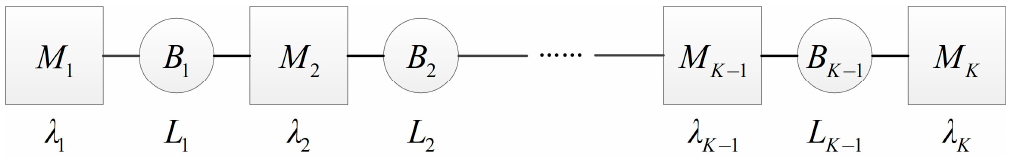
Figure 1. The typical layout and structure of automatic production line, where B i ( i = 1, 2, . . . , K ) is the buffer area, L i ( i = 1, 2, . . . , K ) is the corresponding buffer capacity, λ i ( i = 1, 2, . . . , K ) is the machine failure rate, and it is assumed that the time between failure (TBF) of each machine is Weibull distribution.